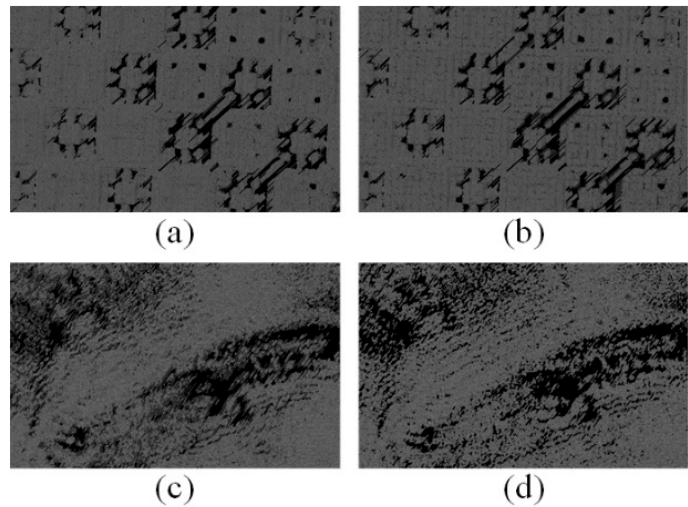
Figure 6. Canny operator edge detection results. ( a ) The edge detection result of Figure 5a by Canny operator. ( b ) The edge detection result of Figure 4b by Canny operator. ( c ) The edge detection result of Figure 5e by Canny operator. ( d ) The edge detection result of Figure 4d by Canny operator. mean filter method and the median filter method. Thirdly, we use the Canny edge detection results to guide the P-M equation to de- noise the interferogram reconstructed from the high-frequency IMF components. Then